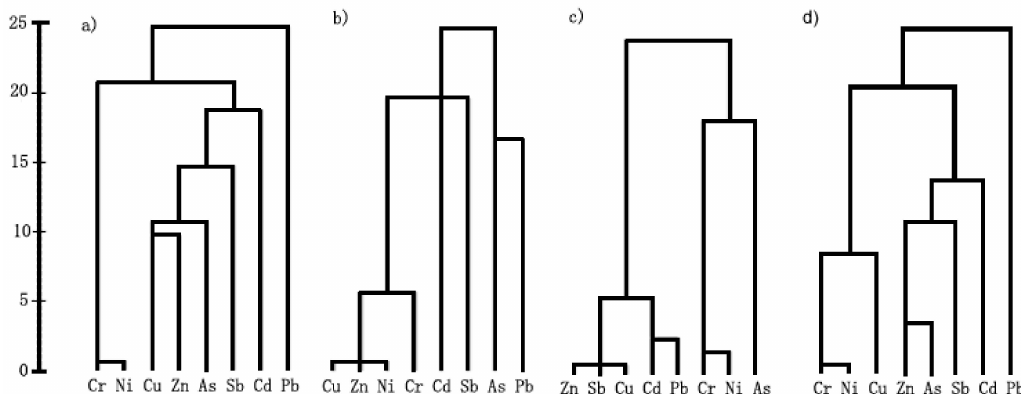
Figure 5. Dendrogram of the cluster analysis of soil heavy metals in ( a ) urban core region, ( b ) suburban region, ( c ) exurban region and ( d ) the whole